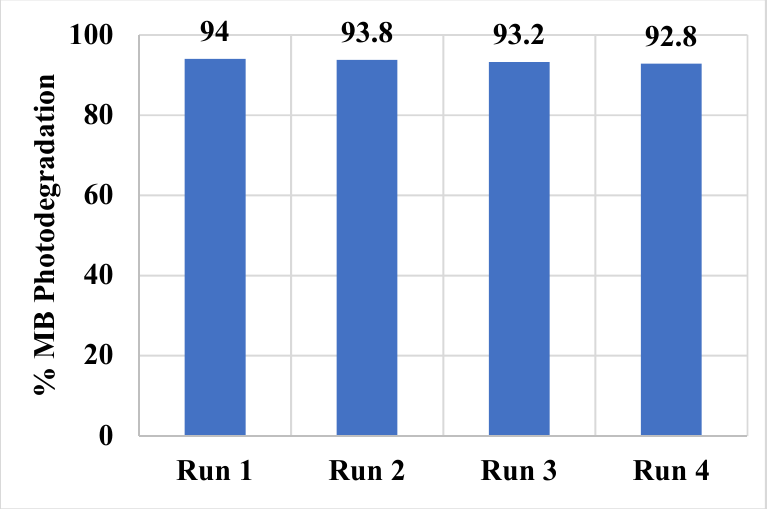
Figure 12. Catalyst recyclability data of NiTiO3/TiO 2 -decorated CNFs after 120 min of visible light irradiation.